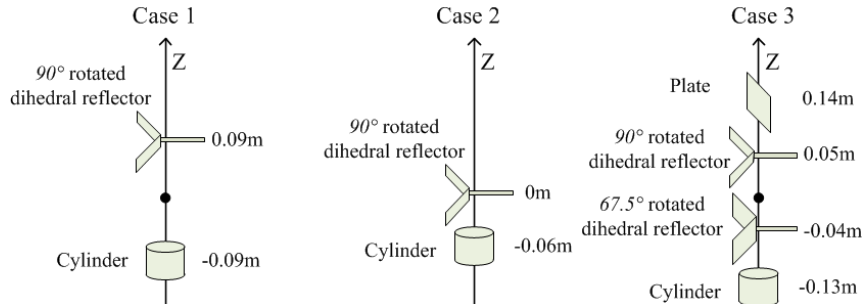
Figure 3. Positions of point scatterers in three cases.